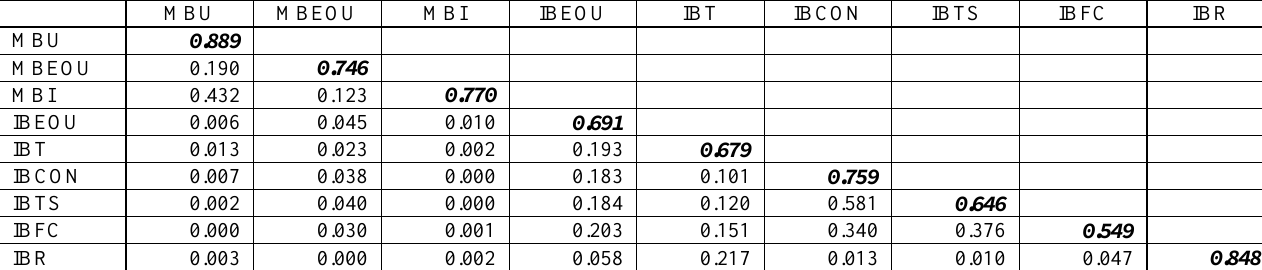
Table 3: Average variance extracted compared with squared